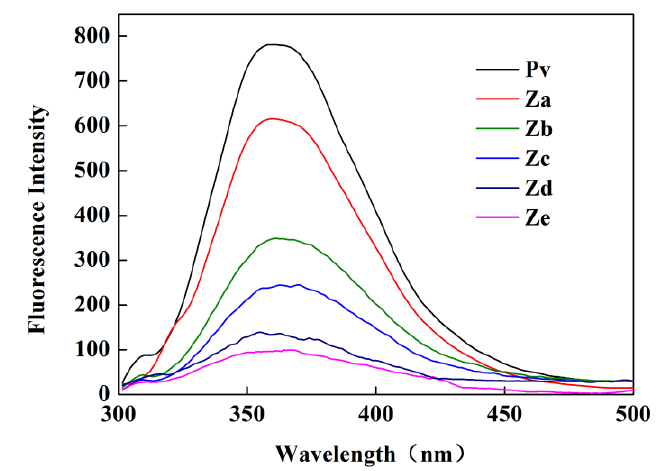
Figure 4. Fluorescence spectroscopy of the Pv–GA complexes.